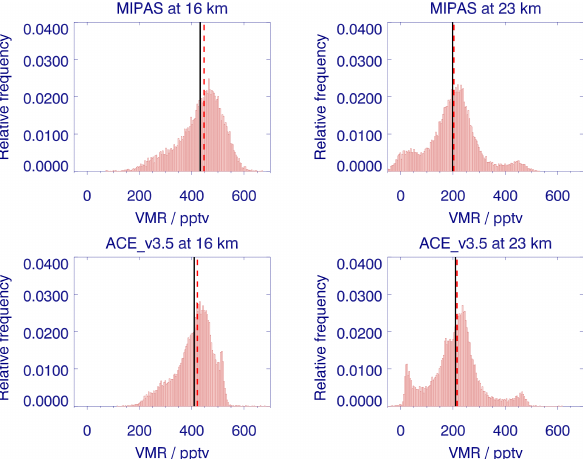
Figure 24. Histogram of MIPAS CFC-12 measurements (top pan- els) and ACE-FTS measurements (bottom panels) for the years of 2005–2012 at 16km (left panels) and 23km (right panels). The black line indicates the location of the mean of the sample, while the red dashed line marks the